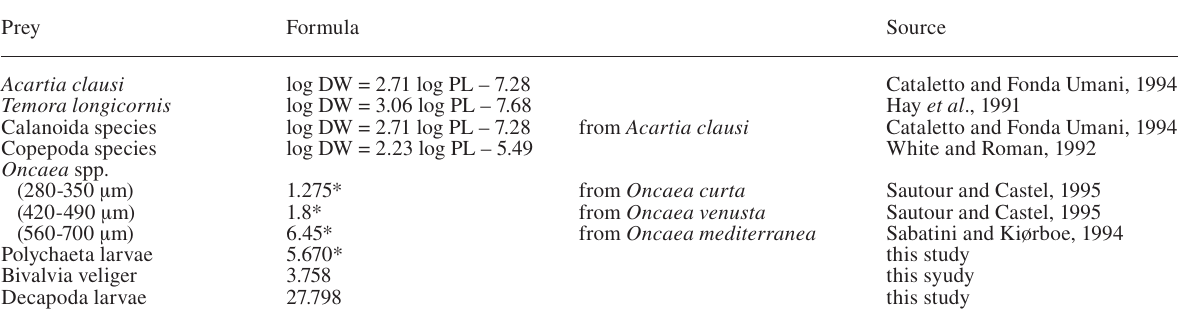
Table 1. – regressions and assigned values of dry weight (DW in μg) of prey in A. minuta . PL = prosome length.